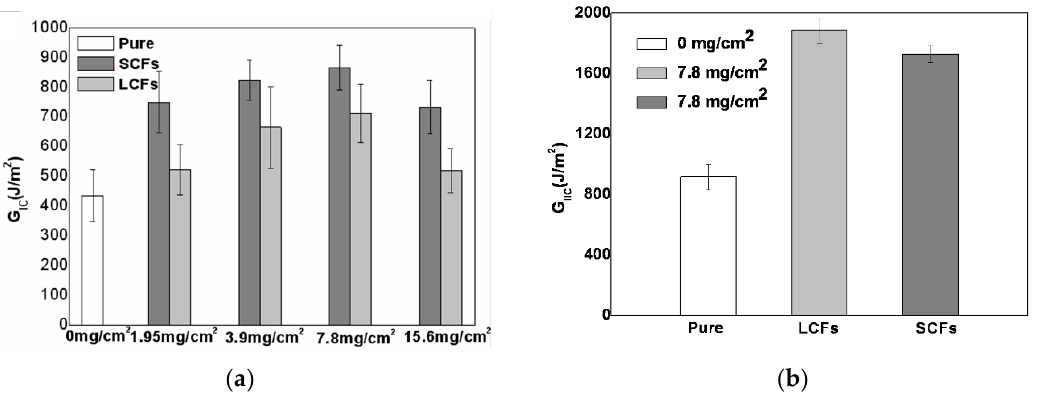
Figure 5. The dependence of ( a ) Mode I and ( b ) Mode II interlaminar fracture toughness of the interleaved CFRPs laminates on the density and fiber length of the NWCT. Table 1. Improvements in Mode I fracture toughness of CFRP composites with carbon interleaves.